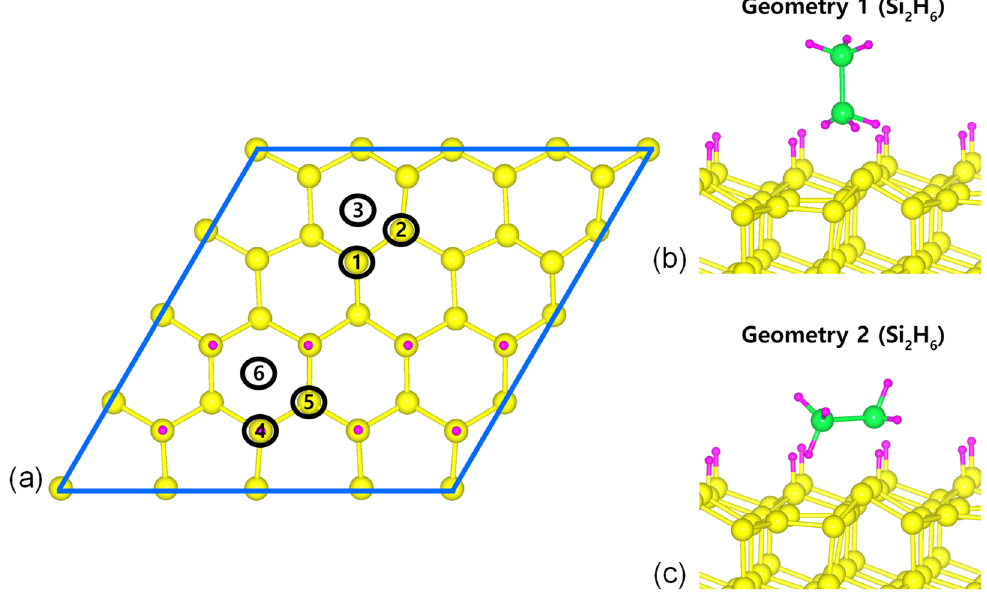
Figure 4. Two geometries and six positions of Si 2 H 6 on the H–50% covered Si(111)-(4 × 4) surface. Solid lines and numbers represent the (4 × 4) unit cells and the molecules adsorption sites, respectively. ( a ) 6 positions; ( b ) Geometry 1; ( c ) Geometry 2.